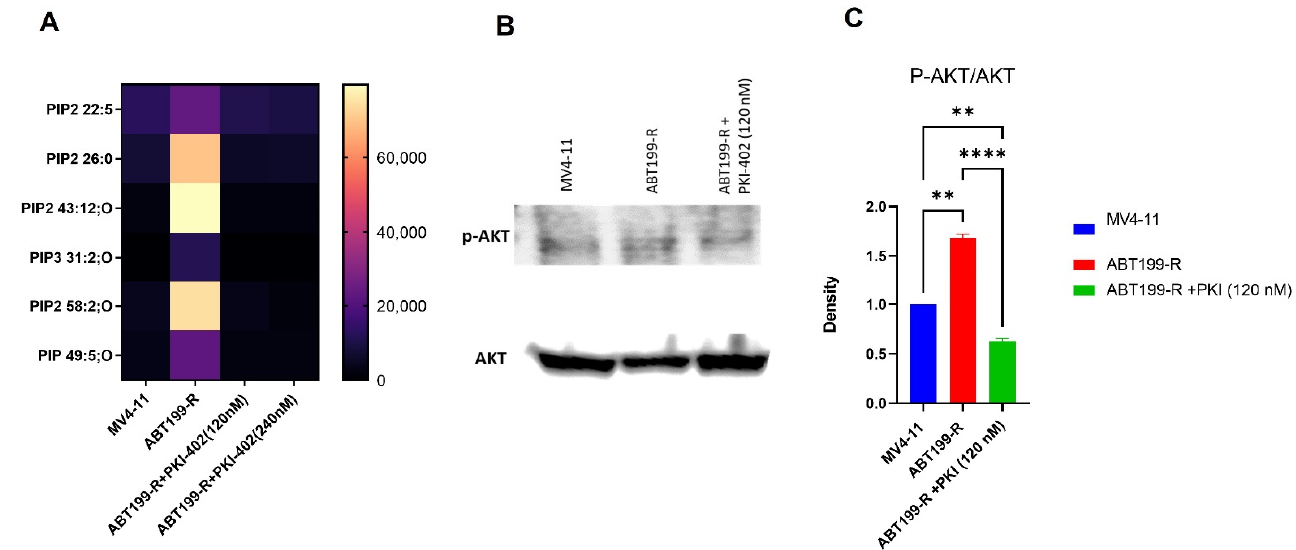
Figure 4. p-AKT signaling pathway in ABT199-R cells. ( A ) Expression of PIP metabolites in MV4-11 cells, ABT199-R cells, and ABT199-R cells treated with PKI-402. ( B ) Western blot analysis of p-AKT and AKT in MV4-11 cells, ABT199-R cells, and ABT199-R cells treated with PKI-402. ( C ) Densitometer analysis of Western blot analysis of p-AKT/AKT in MV4-11 cells, ABT199-R cells, and ABT199-R cells treated with PKI-402. ** p < 0.01 and **** p < 0.0001.